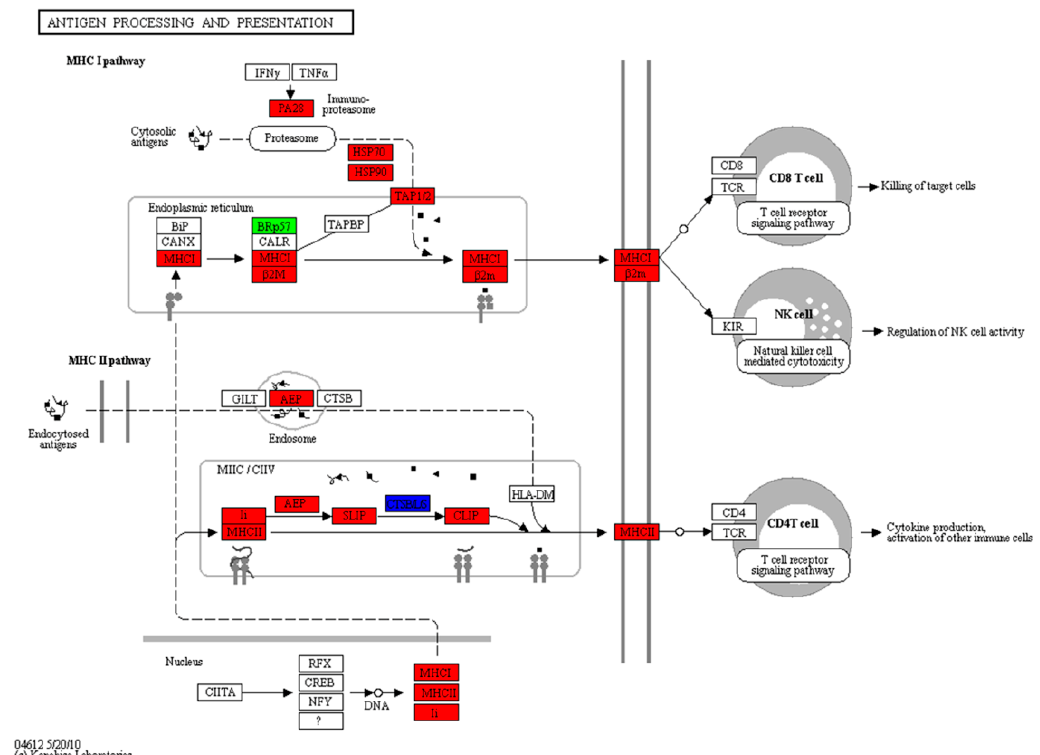
Figure 9. Significantly differentially expressed genes identified by KEGG as involved in the antigen processing and presentation pathway. Red indicates up-regulated genes, green indicates down-regulated genes, and blue indicates genes that were both up- and down-regulated. The DEGs included psme1 , psme2 , psme3 , hsc70 , hsp90aa1.2 , tap1 , b2m , b2ml , mhc1zea , cd74a , cd74b , lgmn , ctssb , mhc2dab , si:busm1-266f07.2 , si:busm1-194e12.12 , ctssb.2 , zgc: 100906 , ctssb.1 , and ctsla .